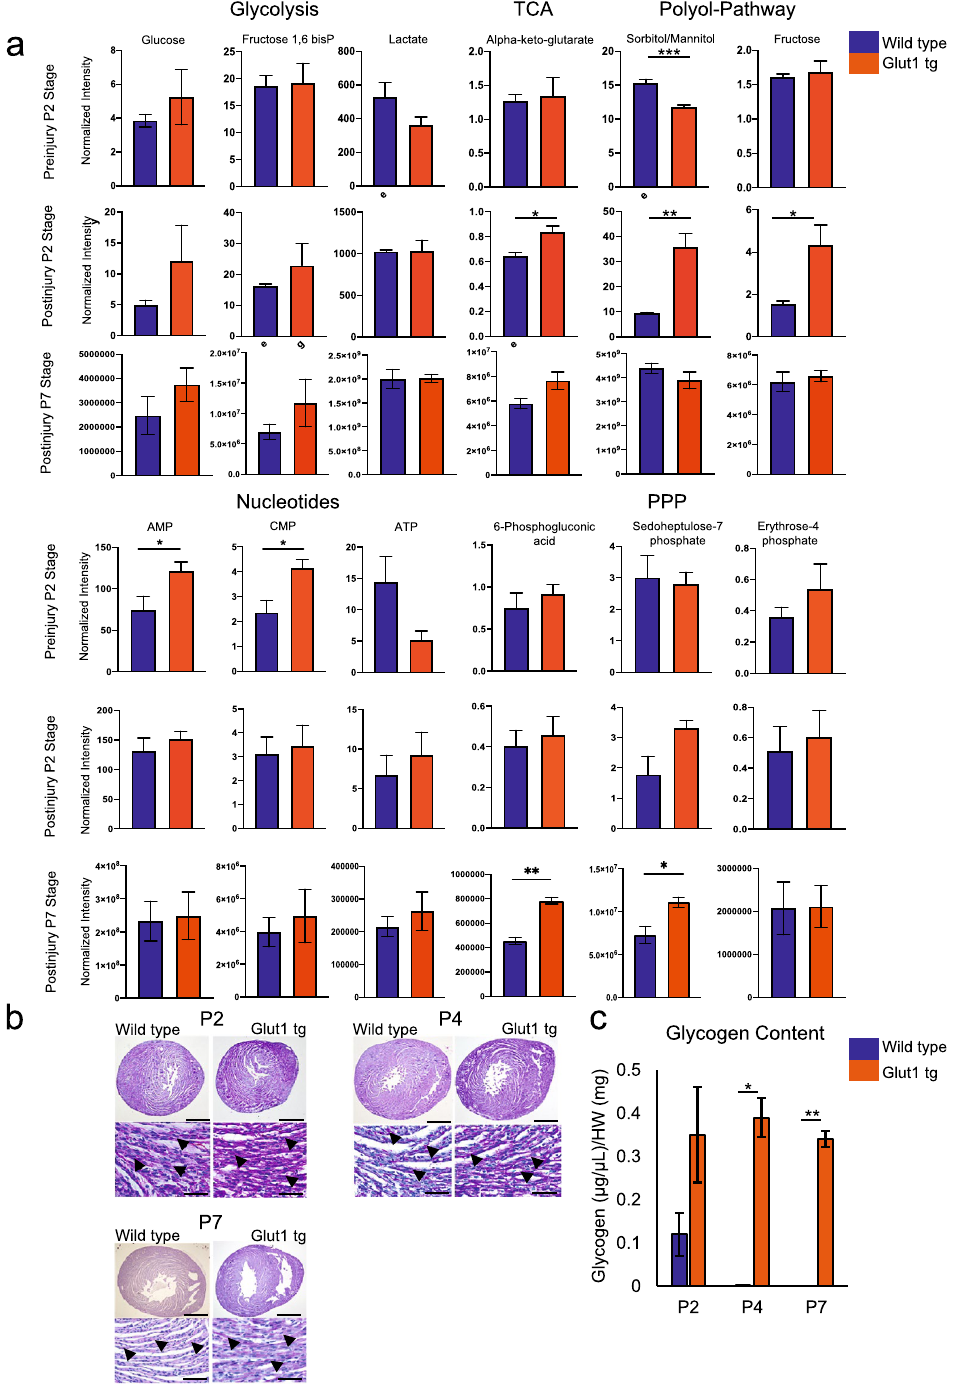
Figure 4. Metabolomics analysis of Glut1 transgenic hearts. ( a ) Metabolomics analysis of Glut1 transgenic hearts and wild type litters at P2 pre-injury and post-injury and P7 post-injury. At P2 stage, overall, the metabolic profile shows no drastic difference at the basal level, but glucose utility increases upon injury as represented by the increase in the metabolites in polyol pathway and glucose. At P7 stage, the metabolic profile showed a statistical differences of intermediates in the Pentose Phosphate Pathway. n = 3 wild type, n = 6 Glut1 tg hearts. * p < 0.05. ** p < 0.01. ( b ) Histological analysis of glycogen storage of Glut1 transgenic hearts and its controls from wild type litters at P2, P4 and P7 by Periodic Acid Staining. Representative images of 3 samples in each group. Scale bar = 200 µm and 20 µm respectively. ( c ) Glycogen quantification by colorimetric assay kit at P2, P4 and P7 stage. n = 3 per group. * p < 0.05. ** p < 0.01. Note the increased intracellular glycogen storage in Glut1 transgenic